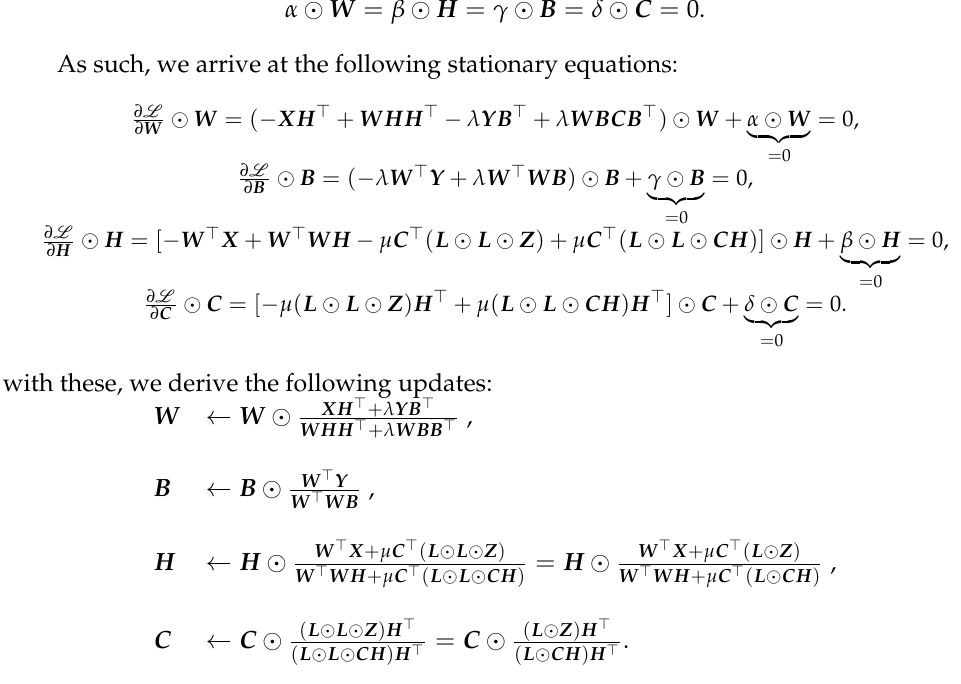
) of Guided C avg